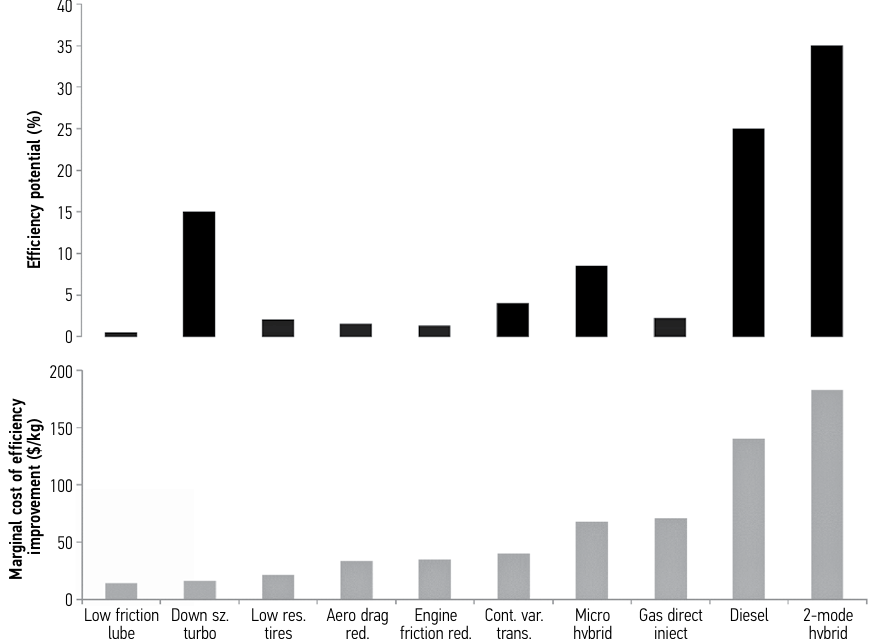
Fig. 7. Estimates for the marginal cost of powertrain efficiency technology sorted from smallest to largest shows that in the most cases, the larger the gain, the larger the marginal